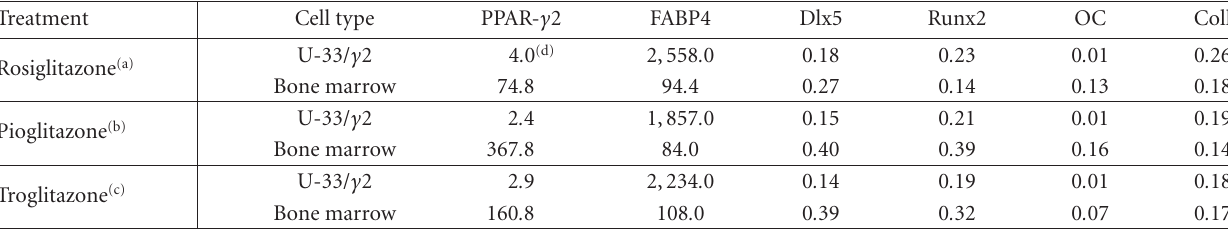
Table 1: The e ff ects of TZDs on osteoblast and adipocyte gene markers. Treatment Cell